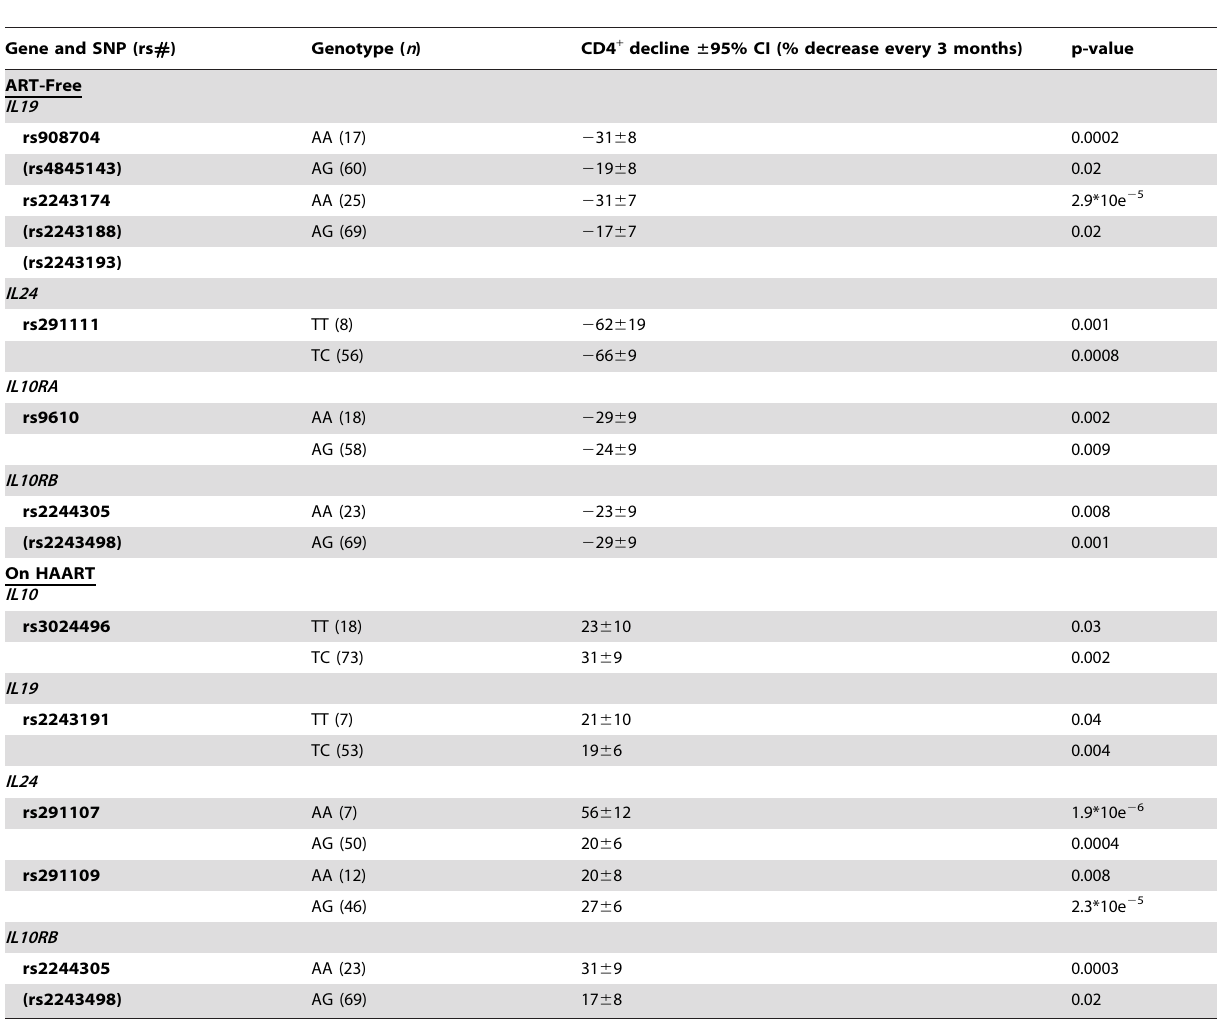
Table 3. Influence of IL10 gene family genotypes on CD4 + T-cell trajectory during a) ART-free period (n=148) and b) HAART